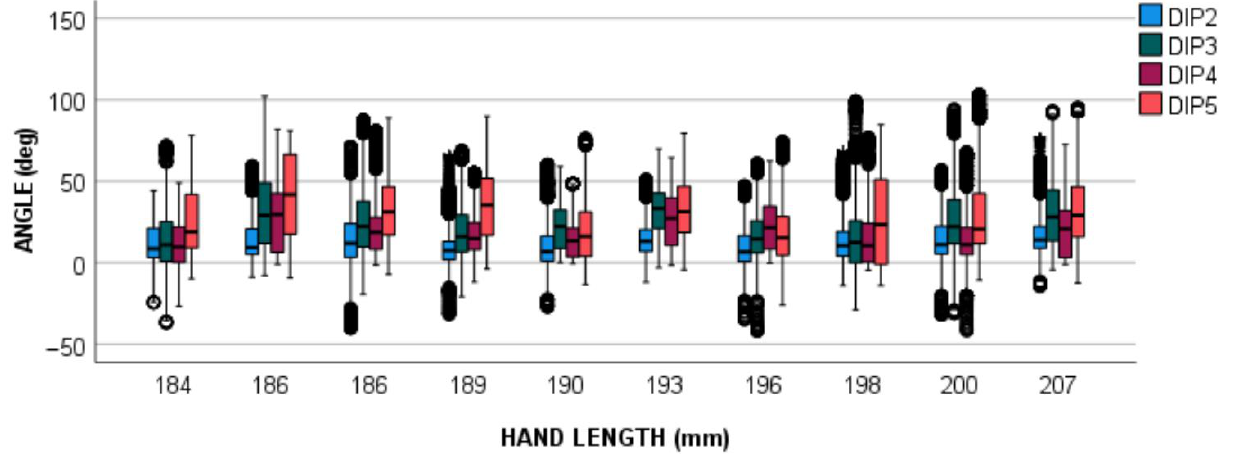
Figure 9. Recorded DIP angles for each subject and finger. Each subject was labeled with his/her hand size (in mm).